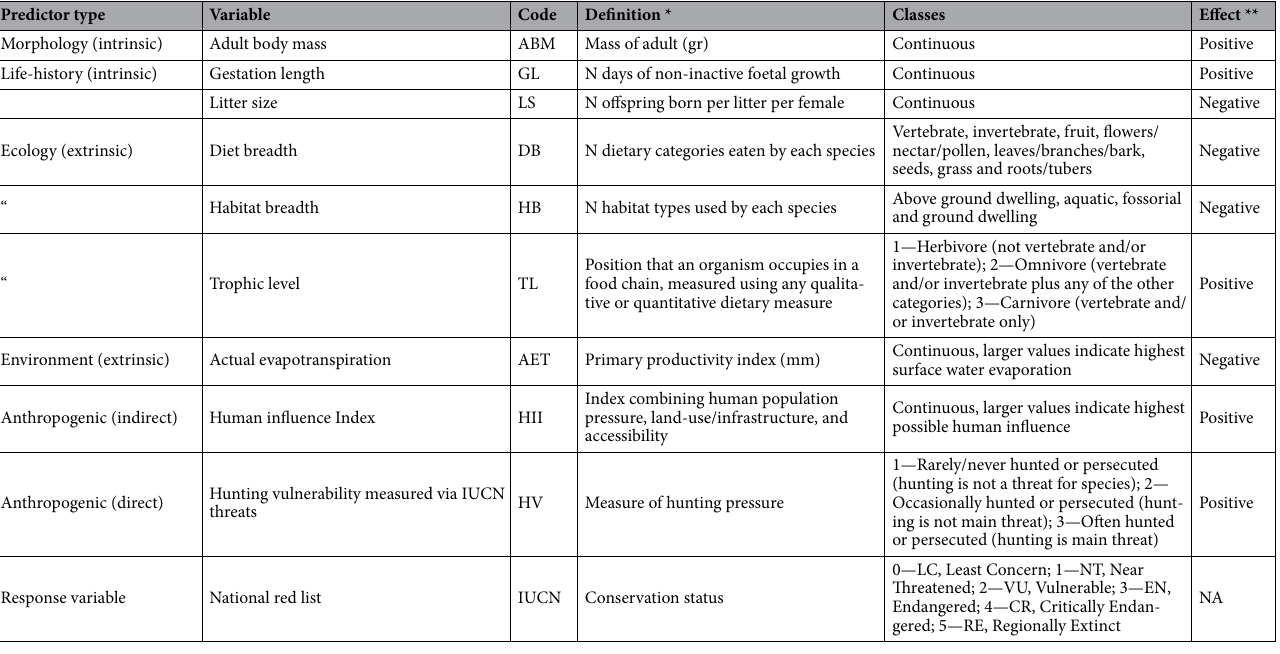
Table 1. Description of variables used in the extinction risk analyses in terrestrial mammals of Iran. See Supplementary Table S1 for details of variables. *See PanTHERIA database 46 for an extended description of the variables and their sources. **The known relationships between predictors and extinct risk. NA, not